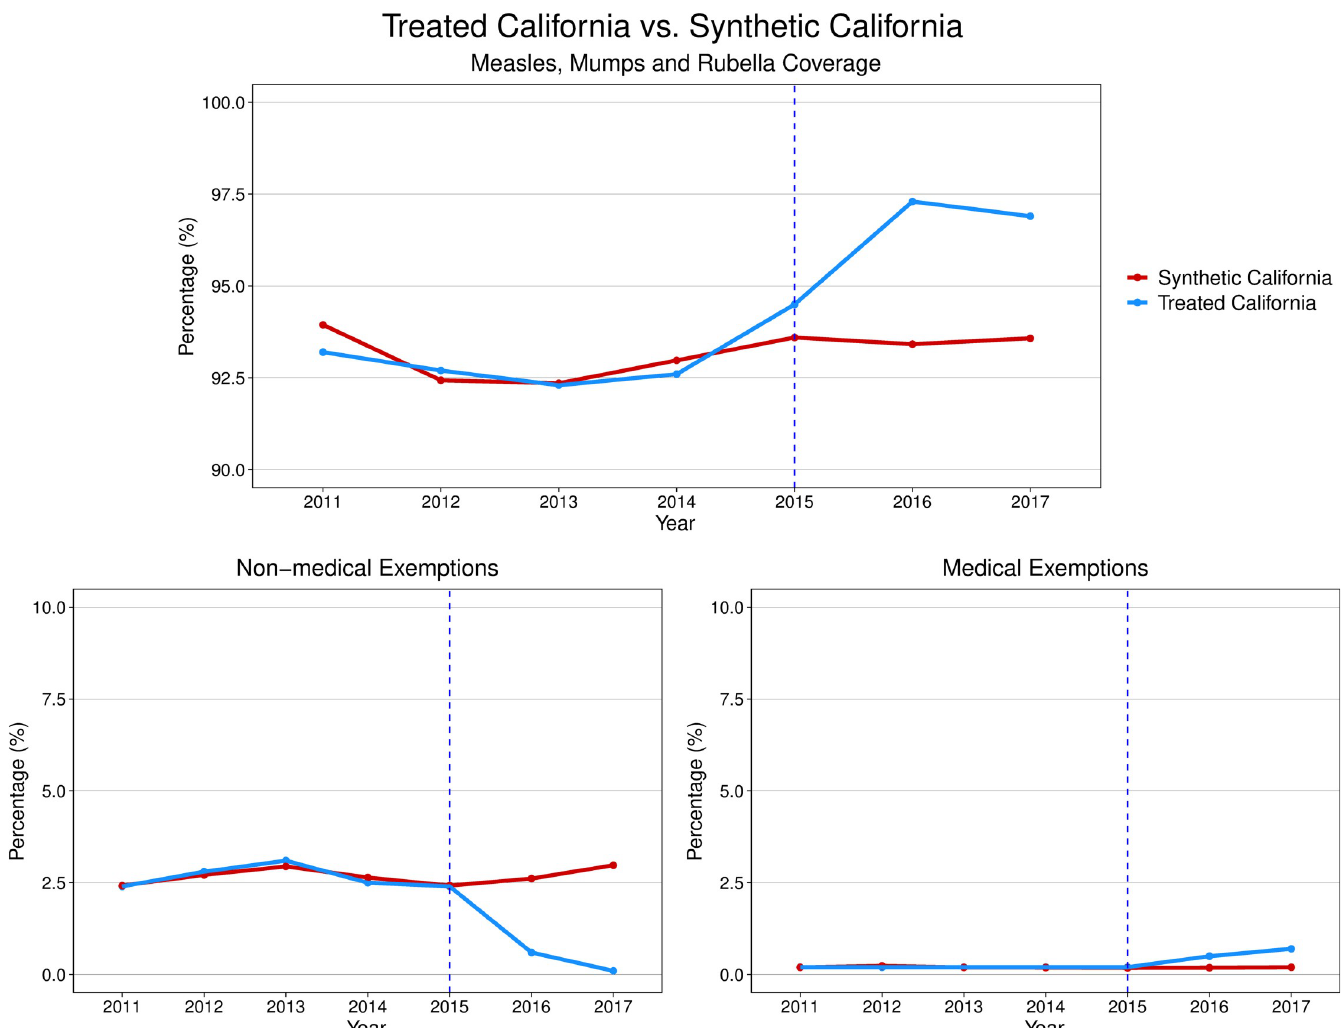
Fig 1. State-level analysis of the 2016 California policy using synthetic control methodology on childhood vaccination and exemption outcomes. We constructed a synthetic control state for California for three study outcomes of MMR coverage (top), nonmedical exemptions (bottom left), and medical exemptions (bottom right). The synthetic control state (red) is estimated to match the study outcomes for actual California (blue) before the policy (indicated by dotted blue line, which is before the 2016–2017 school year). The figure shows the observed difference between the outcome in the actual treated California and the synthetic control California after the policy. MMR, measles, mumps, and